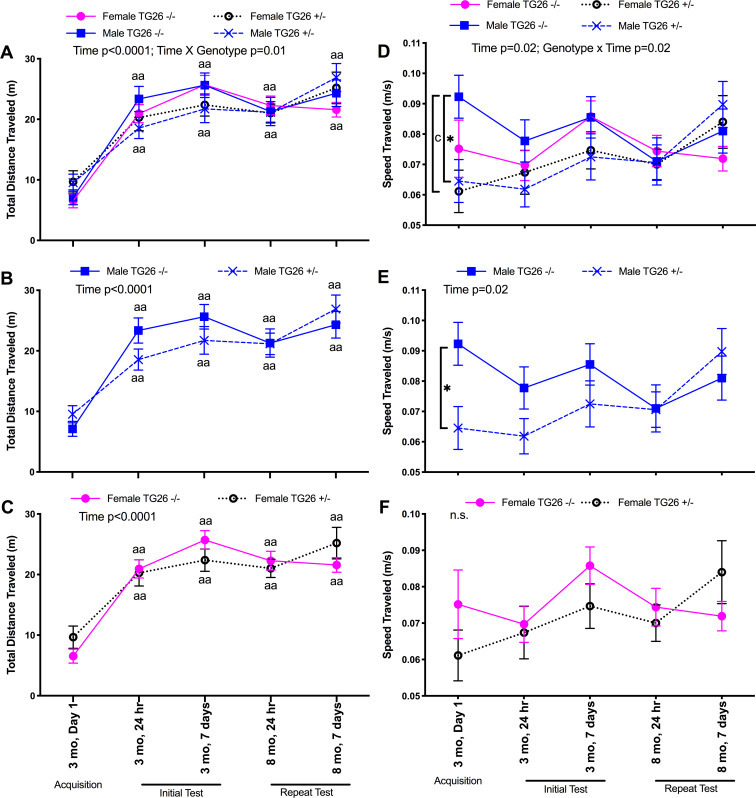
Total distance traveling and speed on the Barnes maze.Assessment of total distance and mean speed on the Barnes maze at 3 and 8 months of age, at two retention probe test points (24 hours and 7 days after completion of acquisition training, which are Days 5 and 12 of Barnes maze testing). (A) Mean total distance on the apparatus during a 300 second Barnes maze test in meters (m). (B) Mean speed on the apparatus in meters per second (m/s). *: p<0.05, compared to wild type -/- mice of same sex; aa: p<0.05 and p<0.01, compared to values obtained for these same animals at 3 months, Day 1; c: p<0.05, compared to opposite sex of opposite genotype. Numbers/group as indicated in Fig 6.